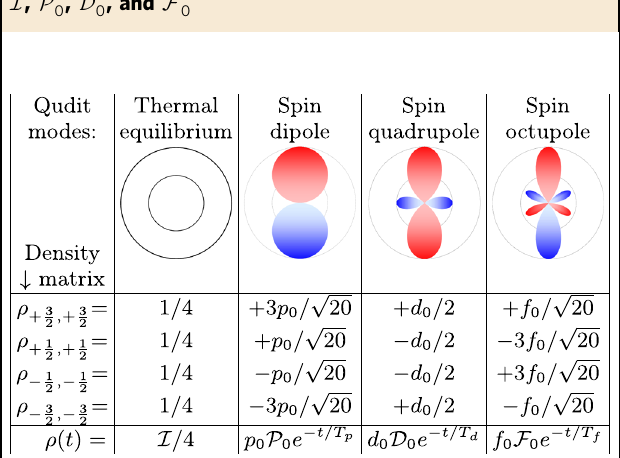
Table 1 Illustration of the V Si spin multipoles and their mathematic representation via the basis diagonal matrices I , P , D , and F 0 0